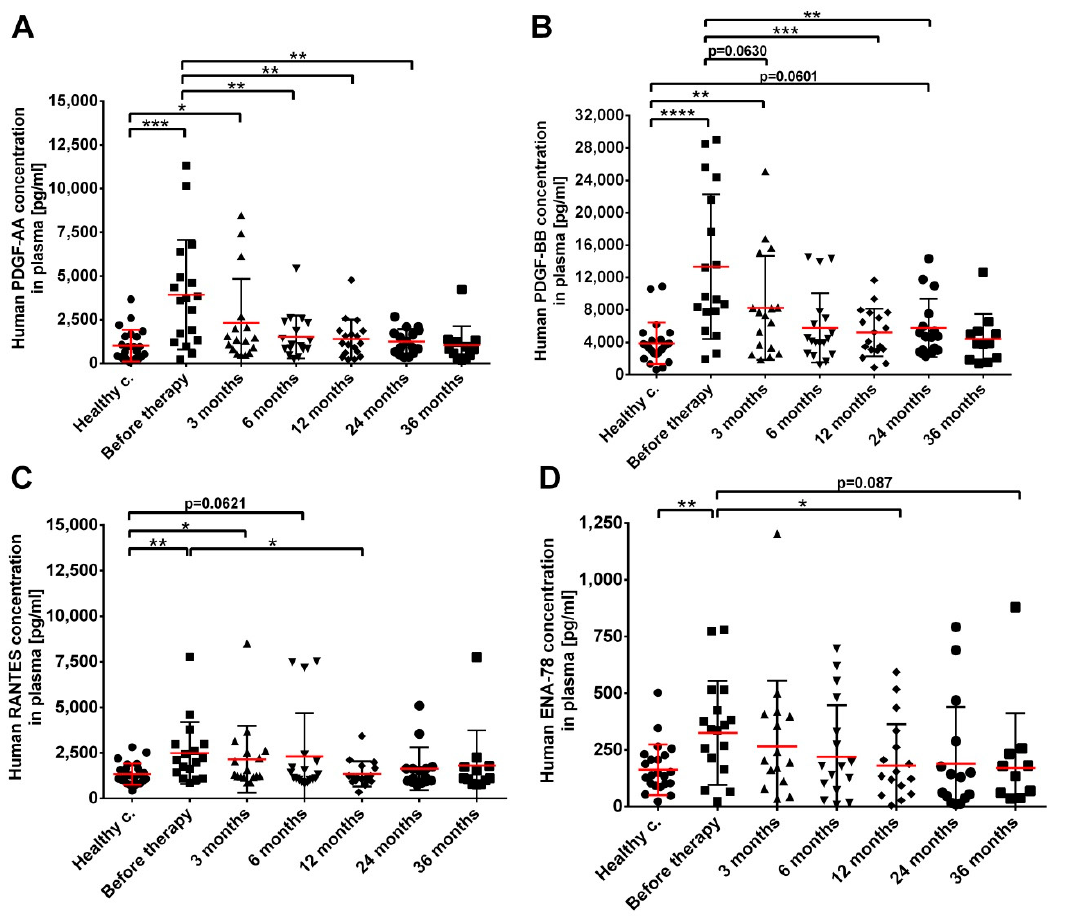
Figure 8. Increased ( A ) PDGF-AA, ( B ) PDGF-BB, ( C ) RANTES/CCL5 and ( D ) ENA-78/CXCL5 levels are associated with the presence of the tumor in prostate cancer patients. Blood collection, processing and plasma analysis was carried out as described in the Materials and Methods at the indicated time points relative to brachytherapy. n (healthy controls) = 24, n (cancer patients) = 12–18. Significant differences were indicated with * ( p < 0.05) ** ( p < 0.01) *** ( p < 0.001) and **** ( p <